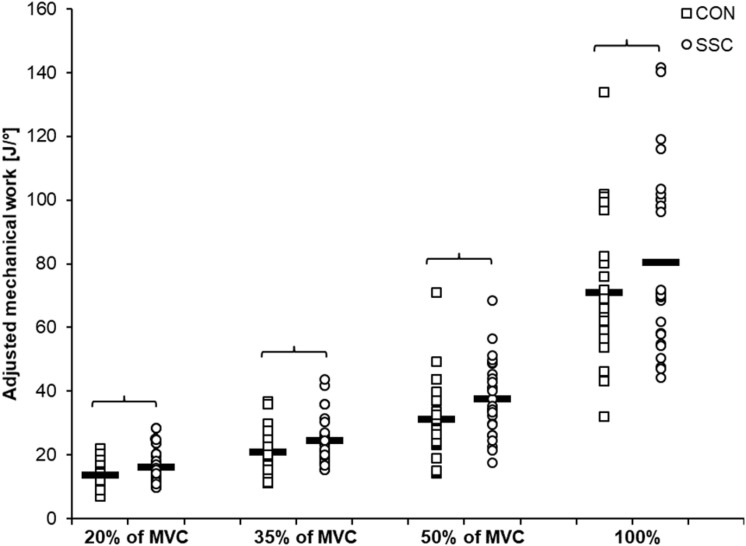
Mean (n = 27, thick horizontal line) (and mean of each individual subjects) values of mechanical work adjusted to the actual knee rotation during the shortening phase. Squares represent concentric condition (CON), whereas circles represent stretch-shortening conditions (SSC). Braces indicate significant (p < 0.05) differences between CON and SSC at the same intensity level.